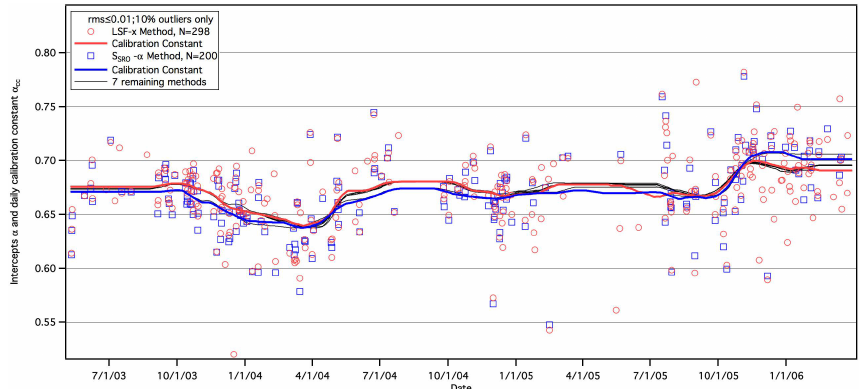
Figure 4. Calibration constants curves for nine methods (rms<0.01) from Langley plots with no more than 10% outliers and individual intercepts α ’s for LSF SRO − x and S SRO - α methods. (The OA and H- β results did not pass the filter of 10% outliers